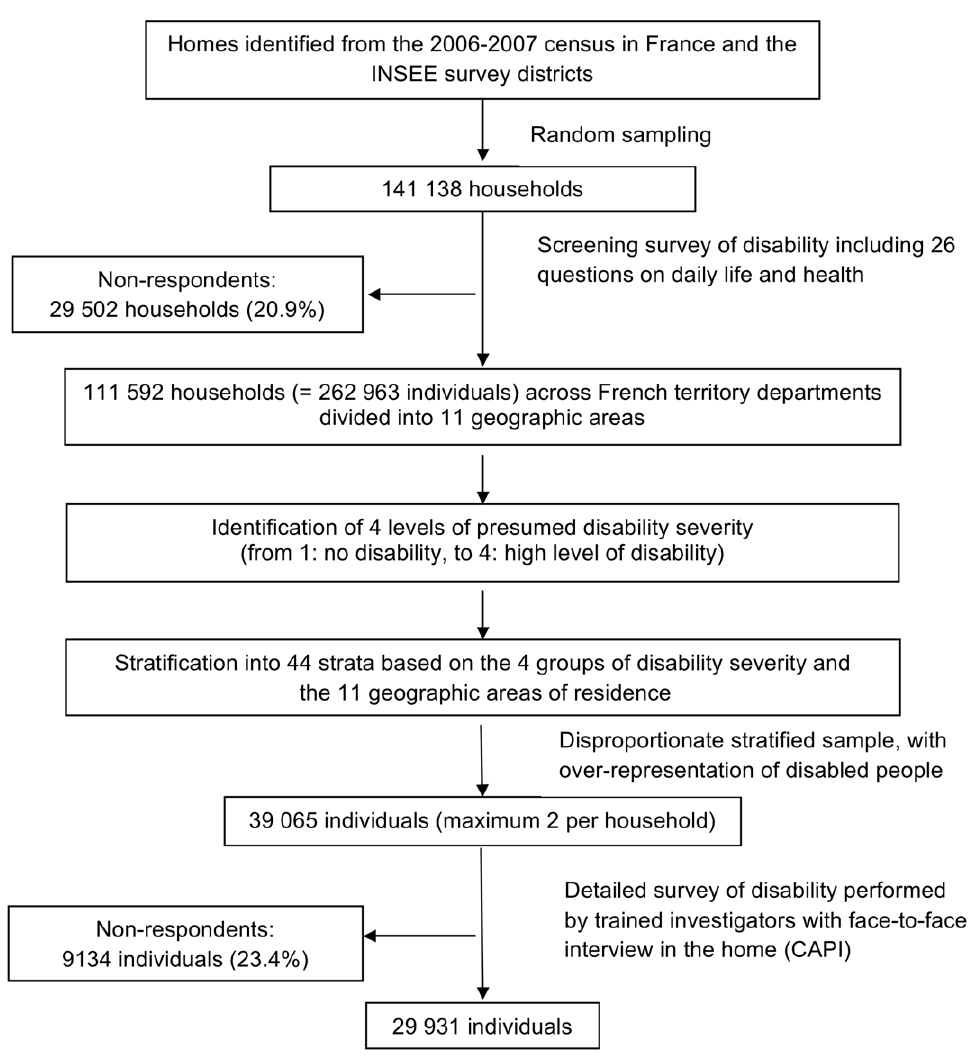
Figure 1. Design of the representative national ‘‘Disability-Health’’ survey. INSEE=French National Institute of Statistics and Economic Studies.